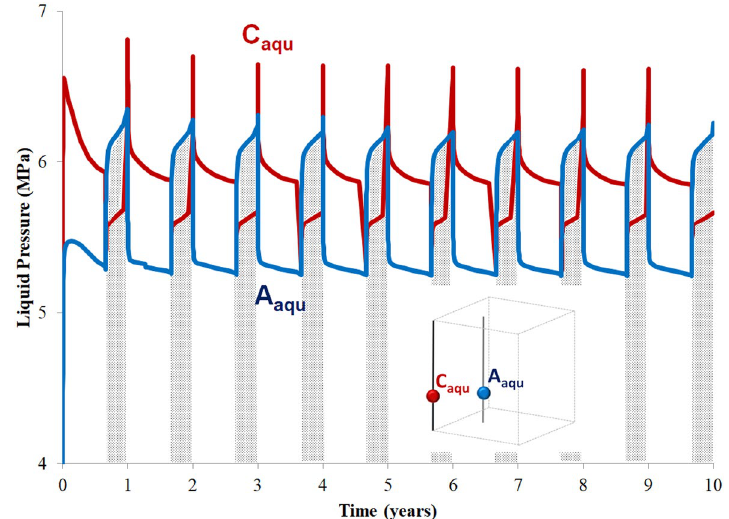
Fig. 8 Evolution of the liquid pressures on the aquifer near central well (C aqu ) near the auxiliary well (A aqu